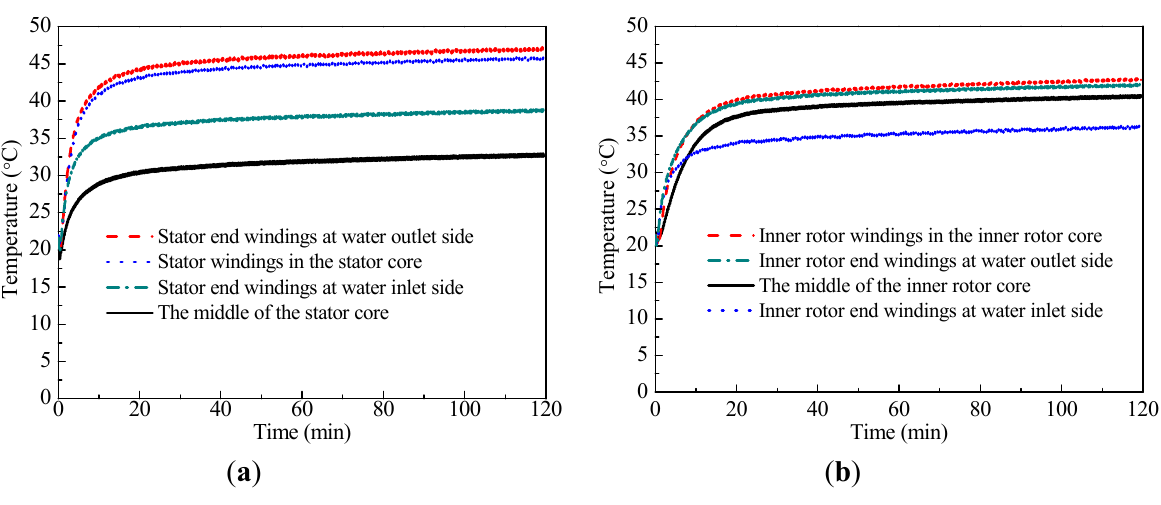
Figure 33. Experimental results when the SM and DRM run at rated torque and low speed, and water cooling and forced air are used in the machine: ( a ) the SM; and ( b ) the DRM.